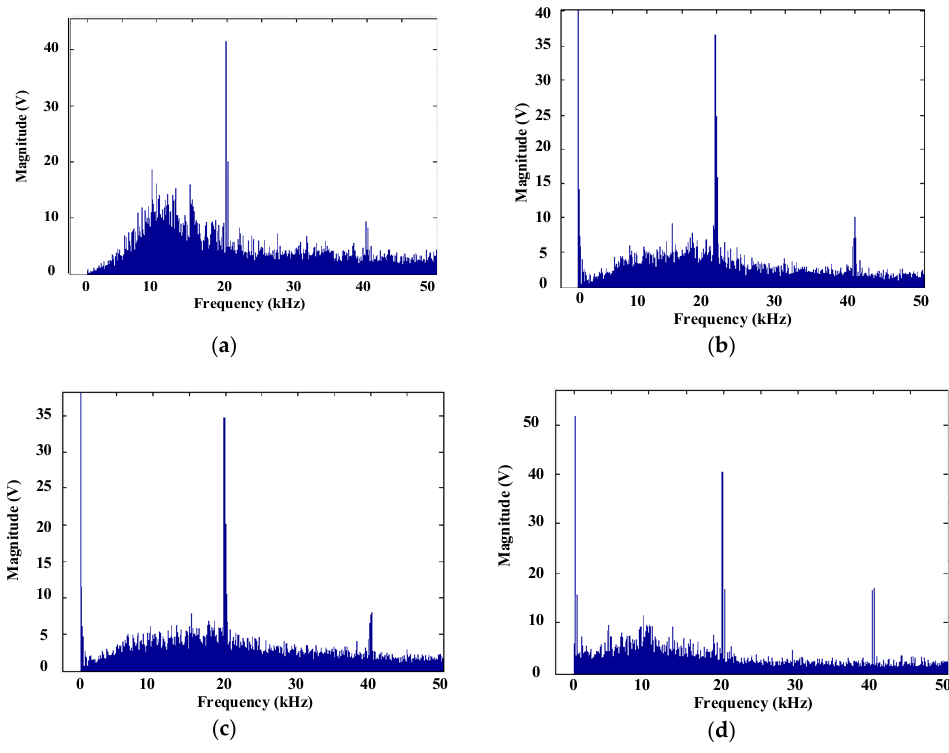
Figure 8. FFT analysis results of CMV ( a ) Conventional MPC, ( b ) Proposed NSV-MPC with PPPP vector, ( c ) Proposed NSV-MPC with NNNN vector, ( d ) Proposed NSV-MPC with active vectors only.